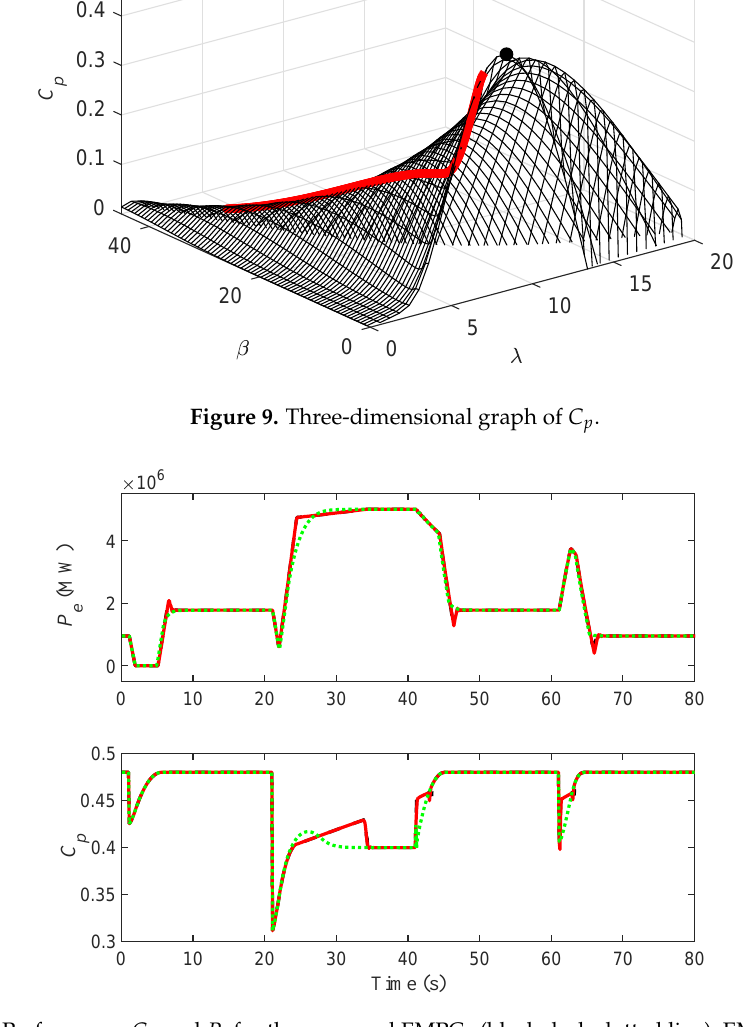
Figure 10. Performance C p and P e for the proposed EMPC 1 (black dash-dotted line), EMPC 2 (red solid line) and classical tracking MPC (green dashed line) under gradient